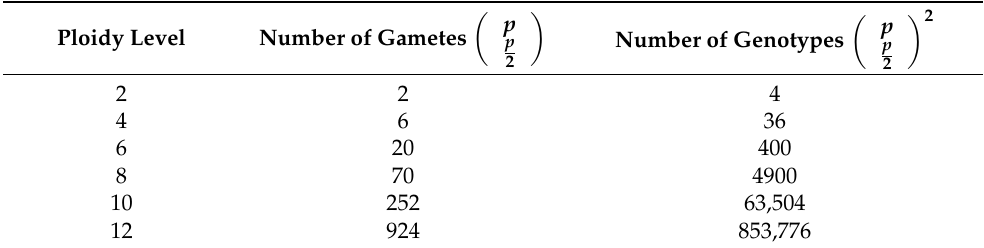
Table 1. Number of possible gametes for one locus with no double-reduction and number of possible genotypes generated by their combination given even ploidy